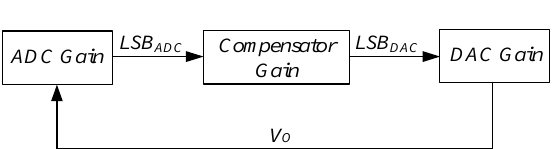
Figure 2. Digital closed-loop system block diagram.